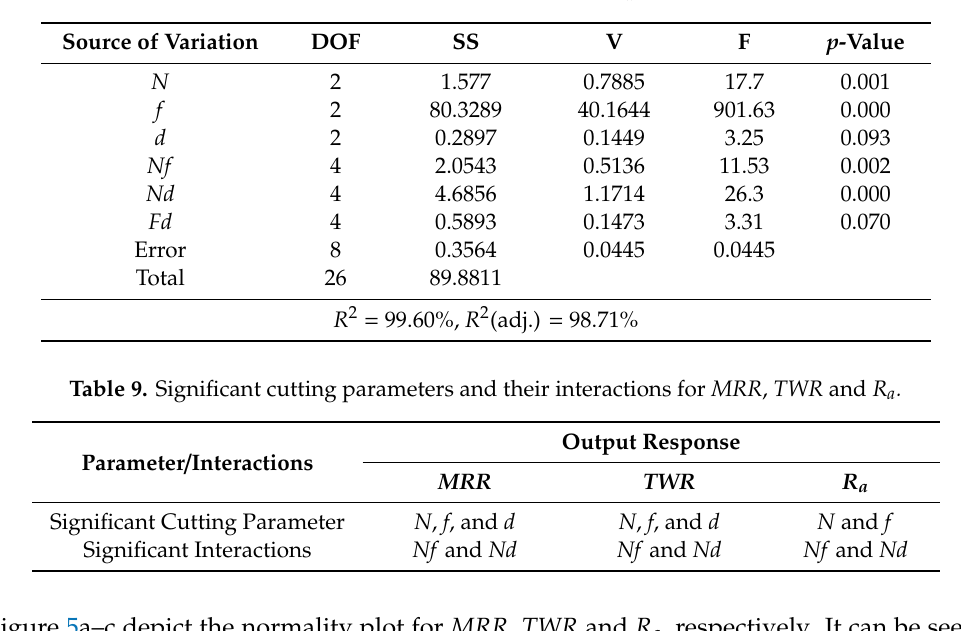
Table 8. ANOVA results for R a .